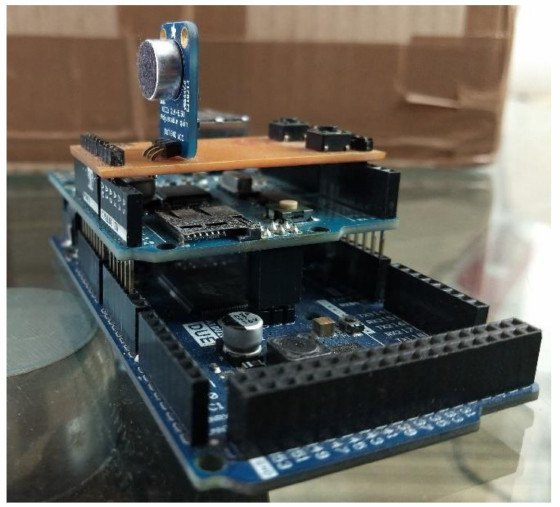
Figure 7. Sound acquisition